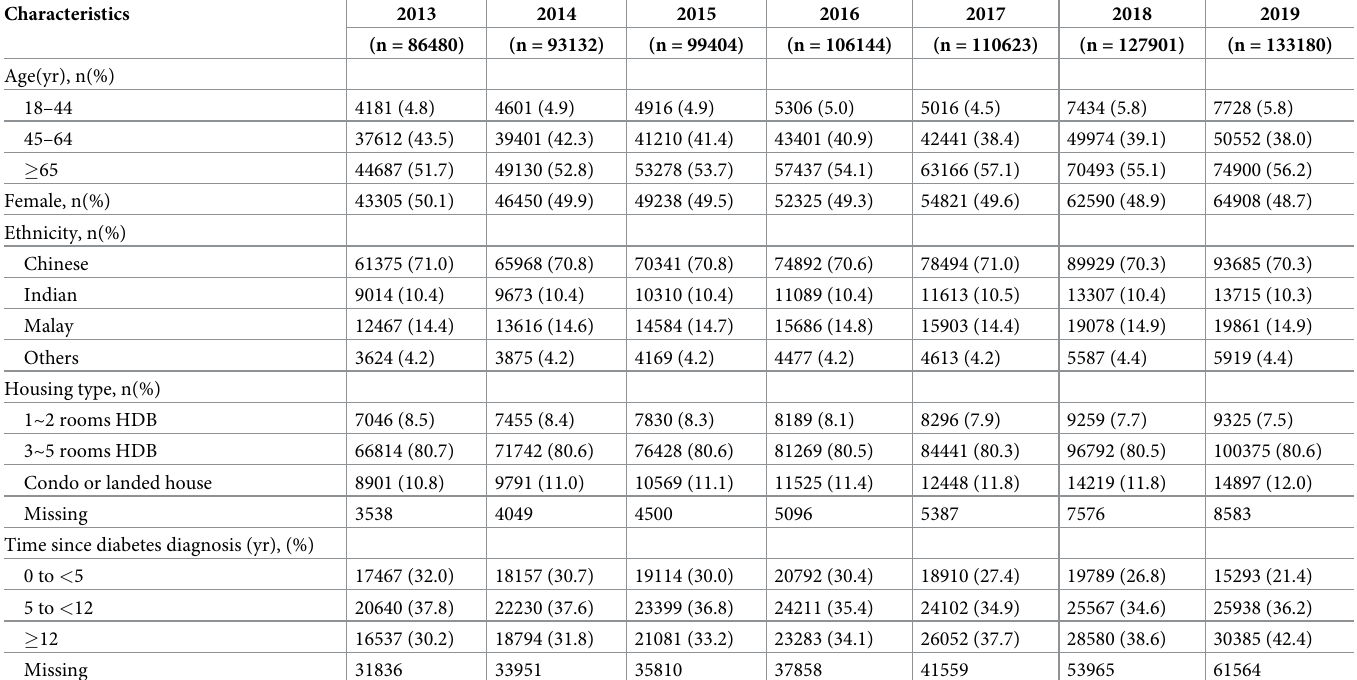
Table 1. Characteristics of patients with